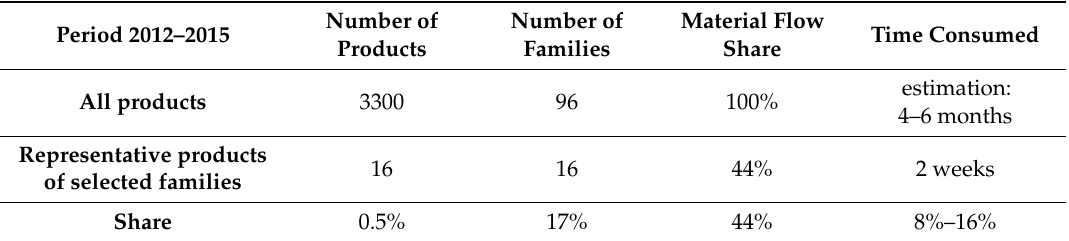
Table 4. The share of material flow inventory and the share of the number of